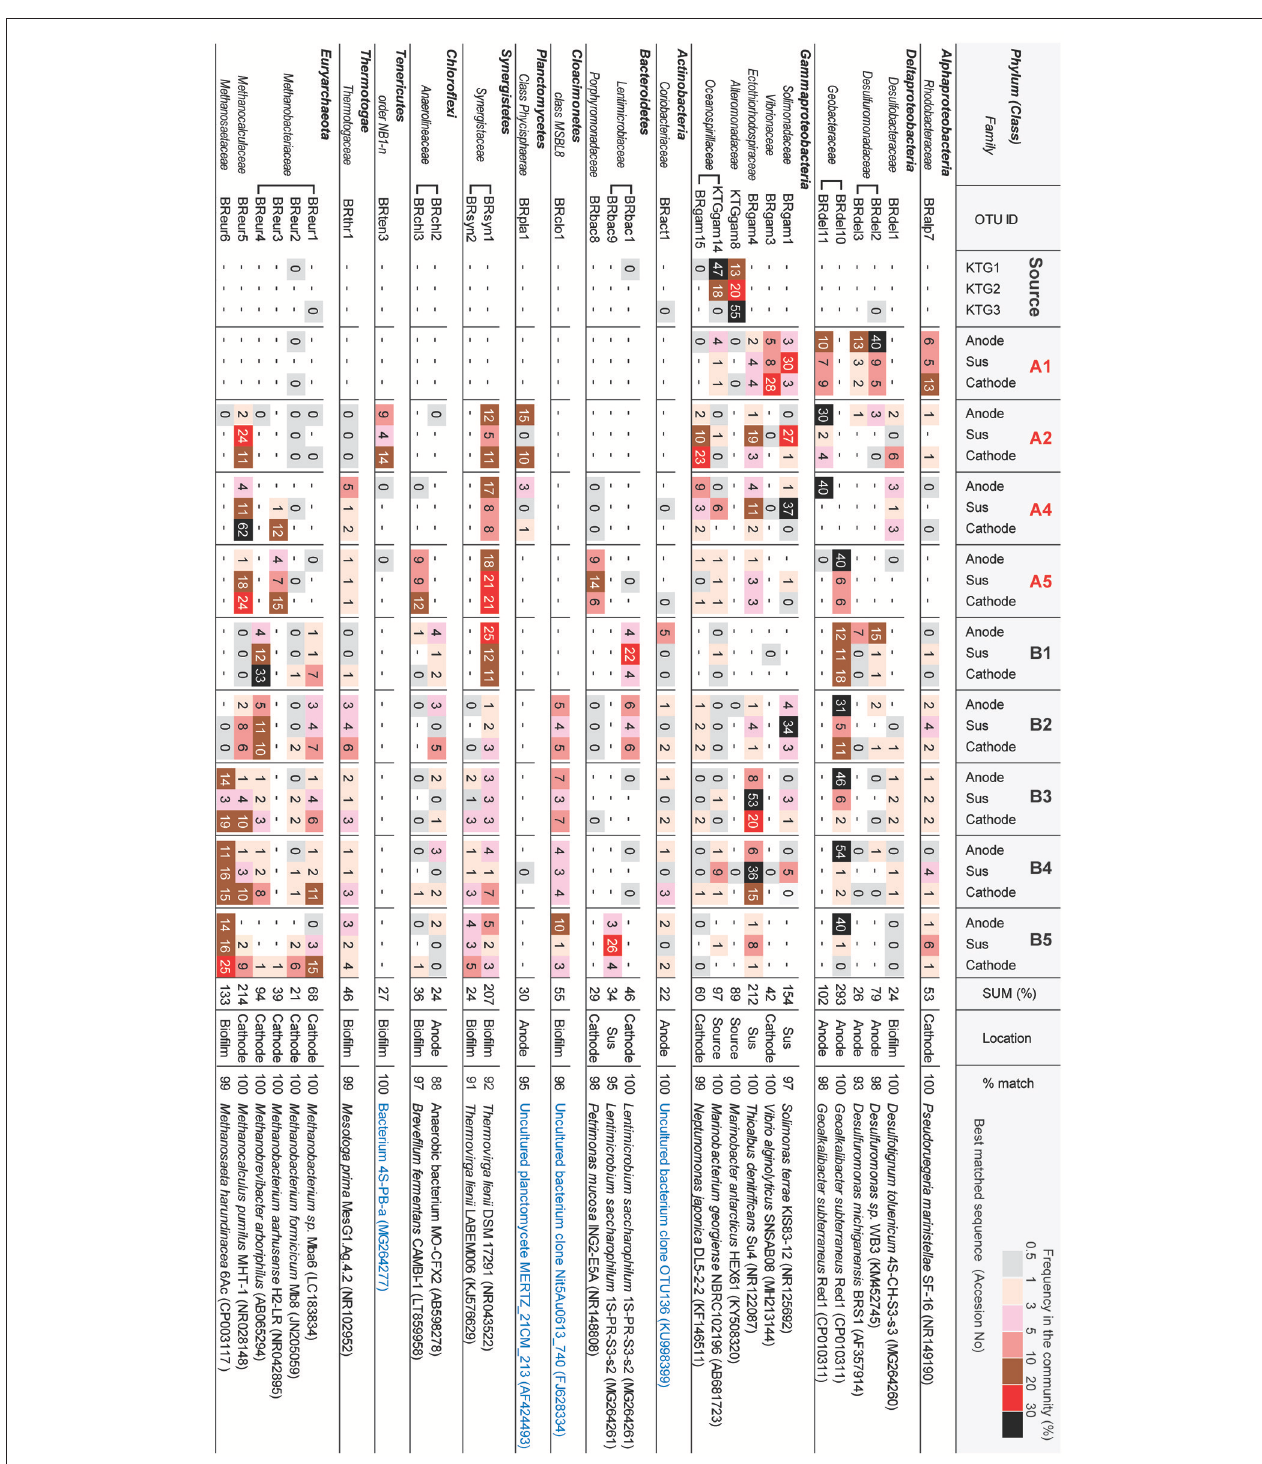
FIGURE 6 | Heatmap table of major phylotypes in the microbial communities. The major phylotypes were selected as those with frequencies that summed to over 20% in all 30 clone libraries. The calculation of frequency (%) was conducted based on Supplemental Table S1 . Best matched sequence was identified by BLAST to nr/nt excluding Uncultured/environmental sample sequences (black letters) or including them (blue letter).